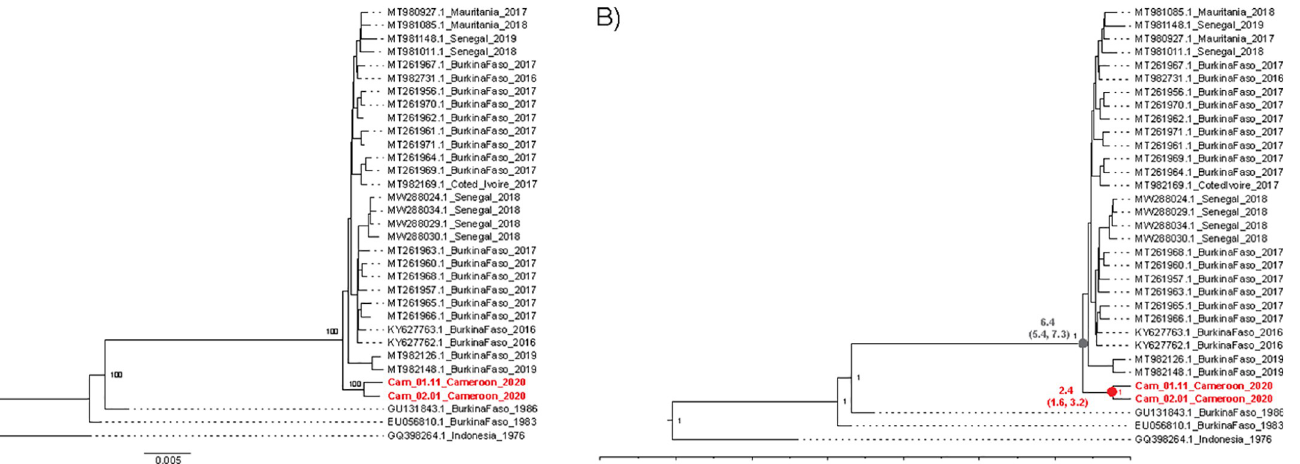
To better understand the extent of ARBV transmission in the region, we tested for IgG anti- bodies to DENV and CHIKV, which revealed a seroprevalence of 24.8% (96/387) for DENV and 15.7% (67/427) for CHIKV ( Fig 2A–2D ). The ELISA testing approach was validated by testing a small random subset of samples for neutralizing antibodies ( Fig 2E and 2F ). All 15 DENV IgG+ samples exhibited neutralizing antibodies to DENV2, the most prevalent DENV serotype identified among non-malarial acute fever cases tested by rRT-PCR. To assess for coherence in ARBV infection, we analyzed the proportion of samples positive for one virus